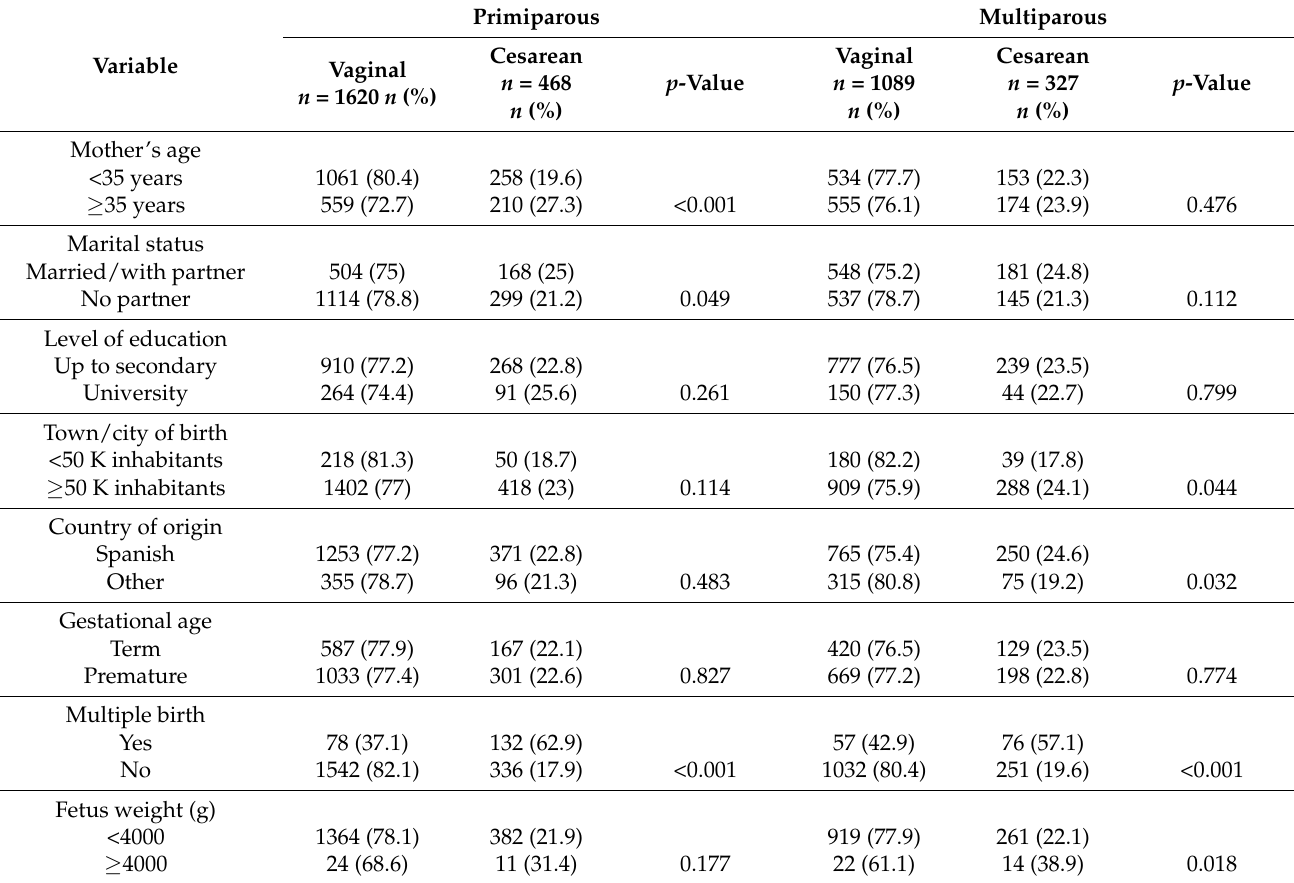
Table 2. Birth mode according to parity in women with a dead fetus from 28 wg. n =